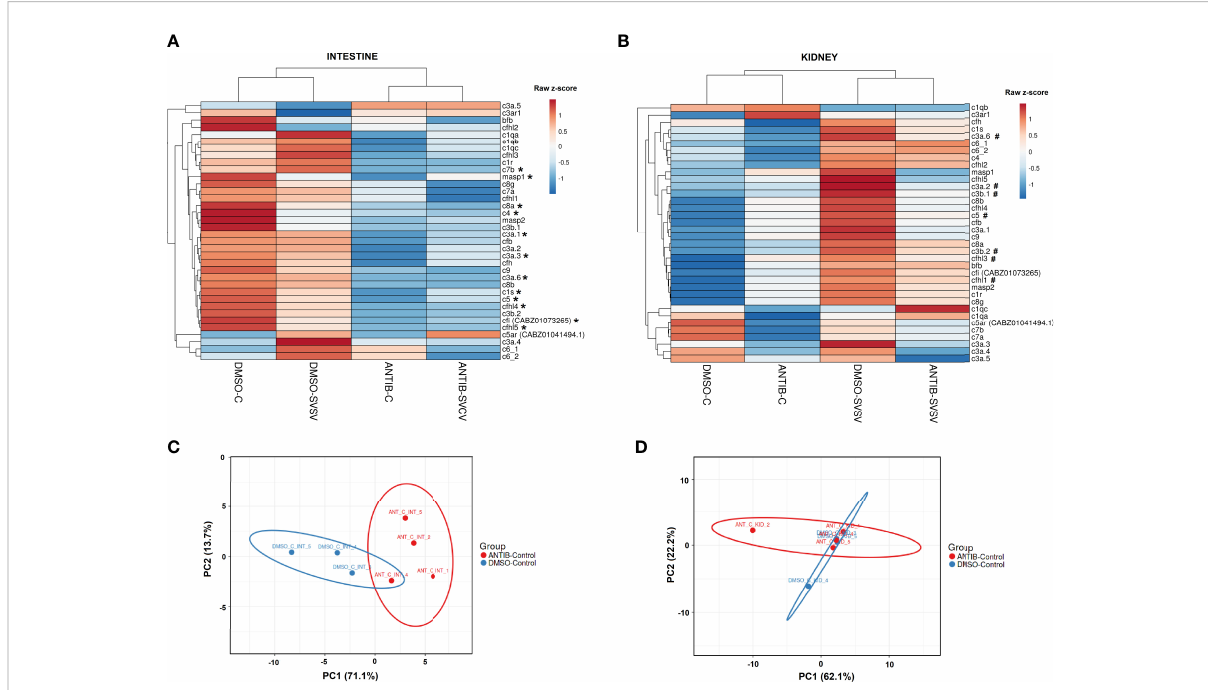
FIGURE 7 Analysis of the complement components. Heatmaps representing the mean TPM values of the different complement components in the (A) intestine and (B) kidney of the four experimental groups (DMSO-C, DMSO-SVCV, ANTIB-C and ANTIB-SVCV). * Indicates statistically signi fi cant differences between the ANTIB-C and DMSO-C groups; # indicates statistically signi fi cant differences between the DMSO-SVCV and DMSO-C groups. PCA of the complement genes in the (C) intestine and (D) kidney of the DMSO-control and antibiotics-control